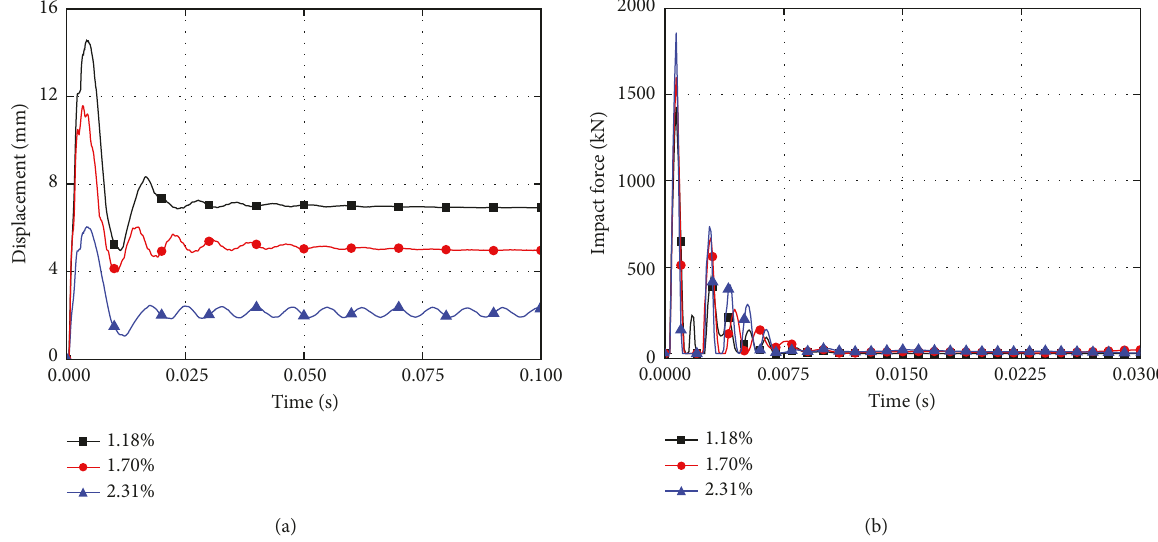
Figure 11: Comparison of impact response of different ratios of longitudinal reinforcement. (a) Comparison of midspan displacement. (b) Comparison of impact